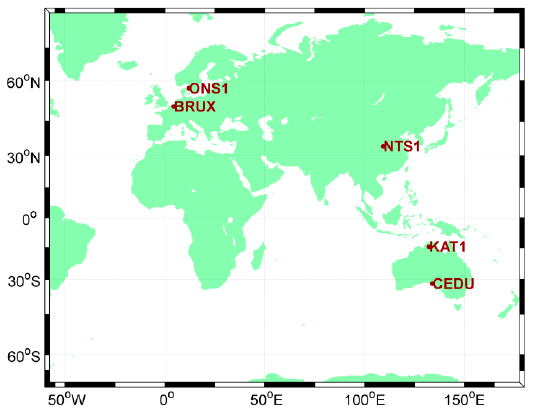
Figure 2. Layouts of multi-GNSS stations, capable of tracking GPS, BDS and Galileo constellations. Table 1. Attributes of stations used in this study.